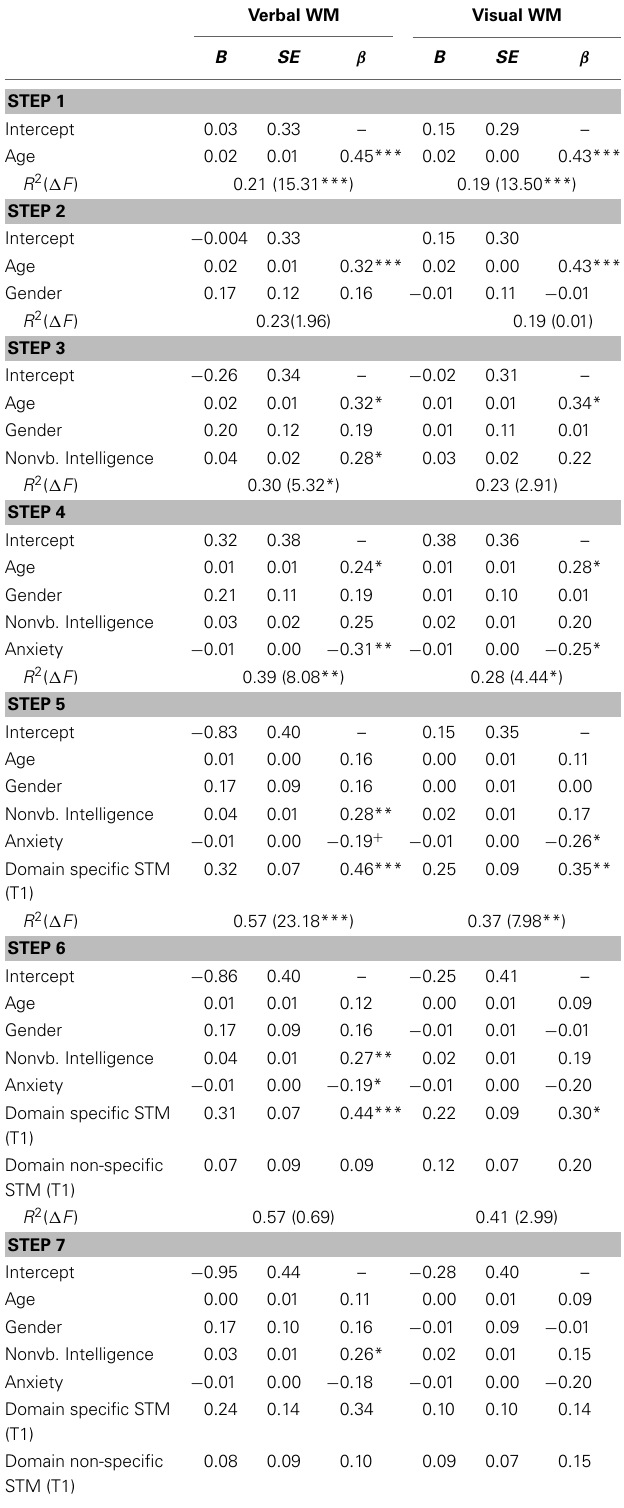
Table 2 | Hierarchical regression models predicting children’s performance on verbal and visuospatial working memory (WM)